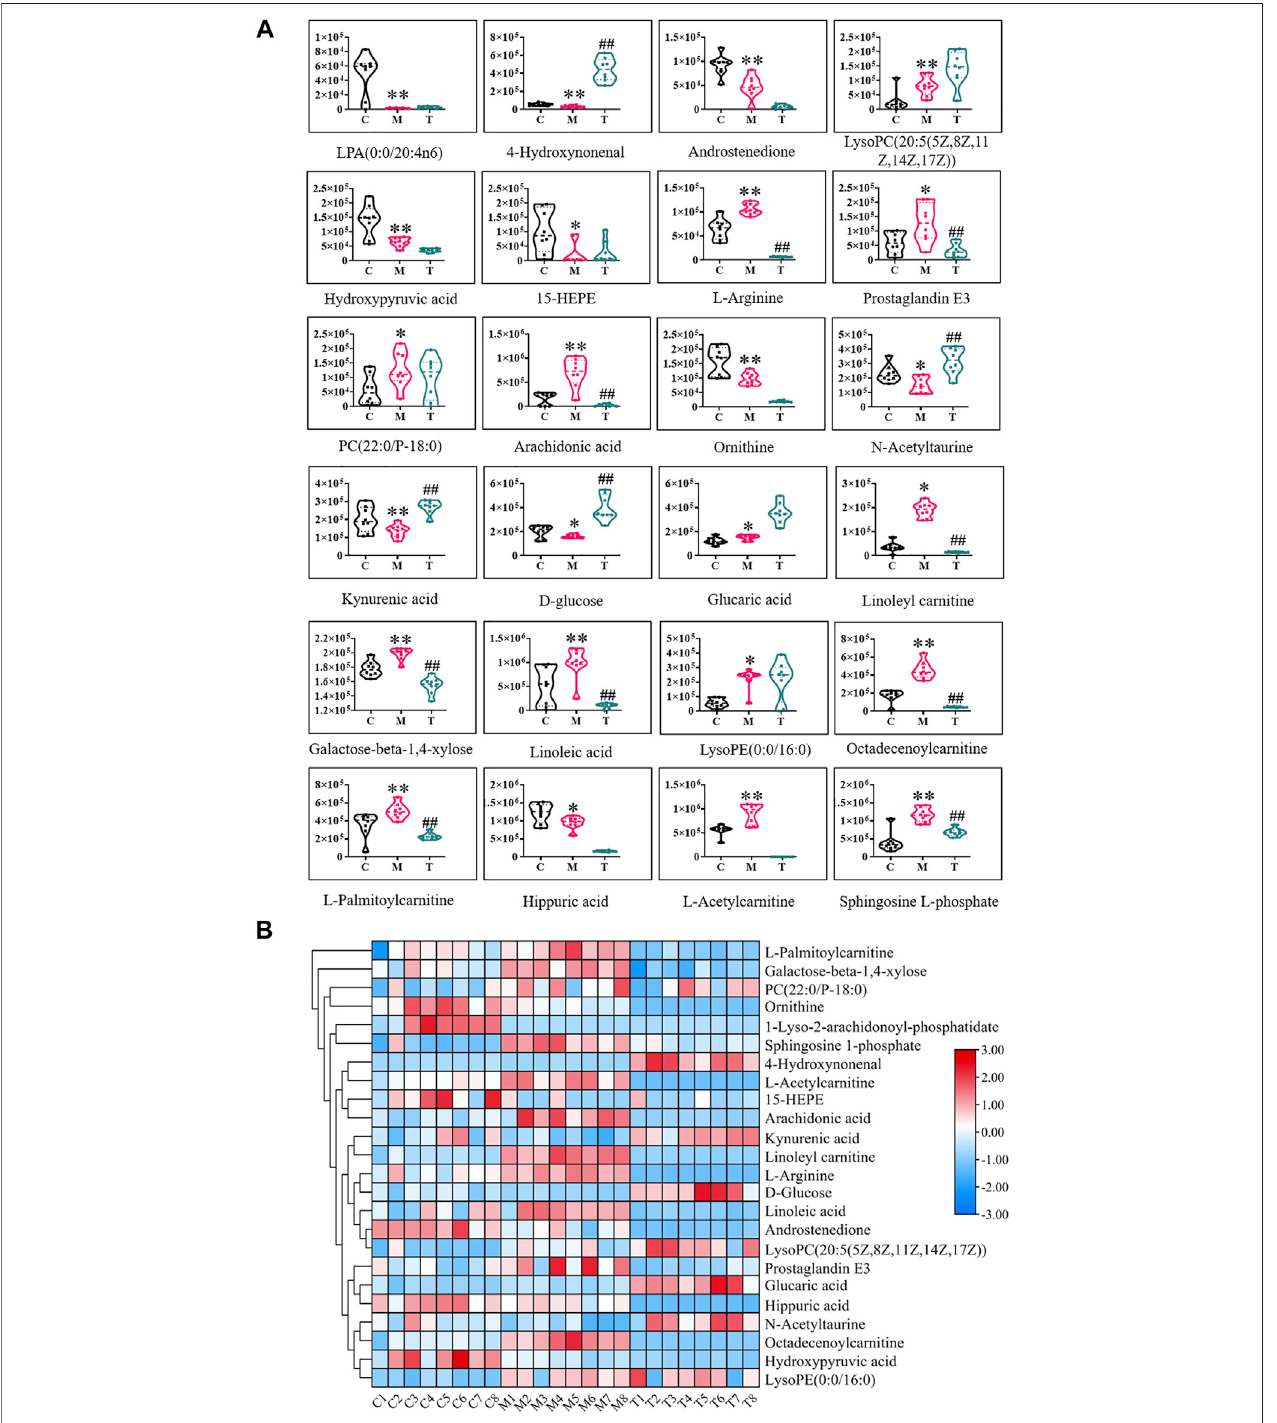
FIGURE 5 | The normalized abundance of potential biomarkers before and after wutou decoction administration. (A) Normalized abundance values between differentgroups (B) Heat map ofthe differences in the potential biomarkers ofthe C,M and T obtained in theESI + and ESI − . Results are expressed asmean ±SD, n = 8. * p < 0.05, ** p < 0.01 vs control group. # p < 0.05, ## p < 0.01 vs model group. C represents control group, M represents model group, T represents wutou decoction group.